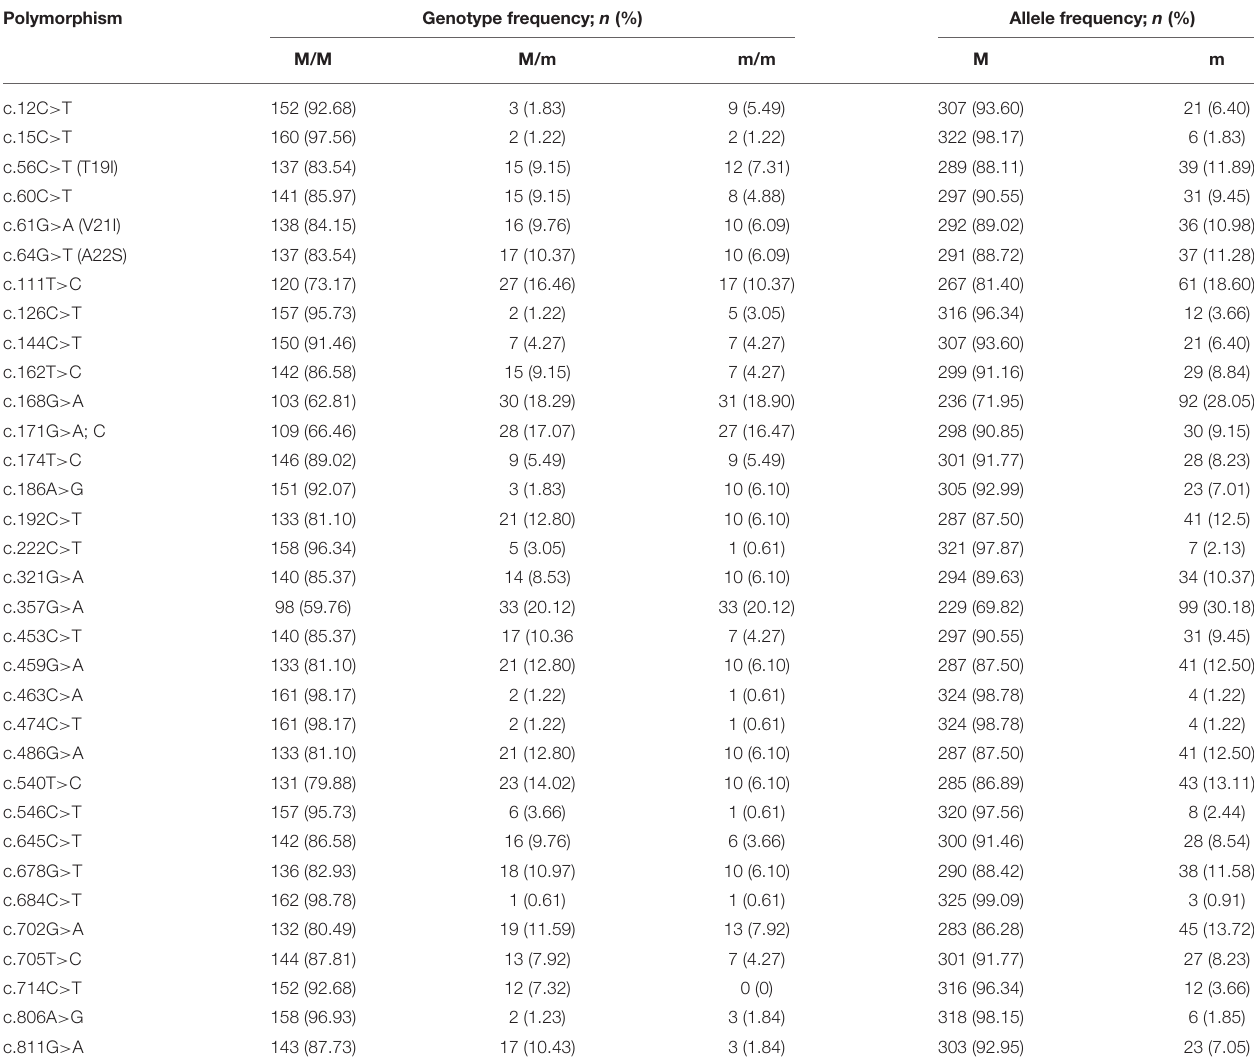
TABLE 2 | Genotype and allele frequencies of the single nucleotide polymorphisms in the quail prion protein gene ( PRNP ).